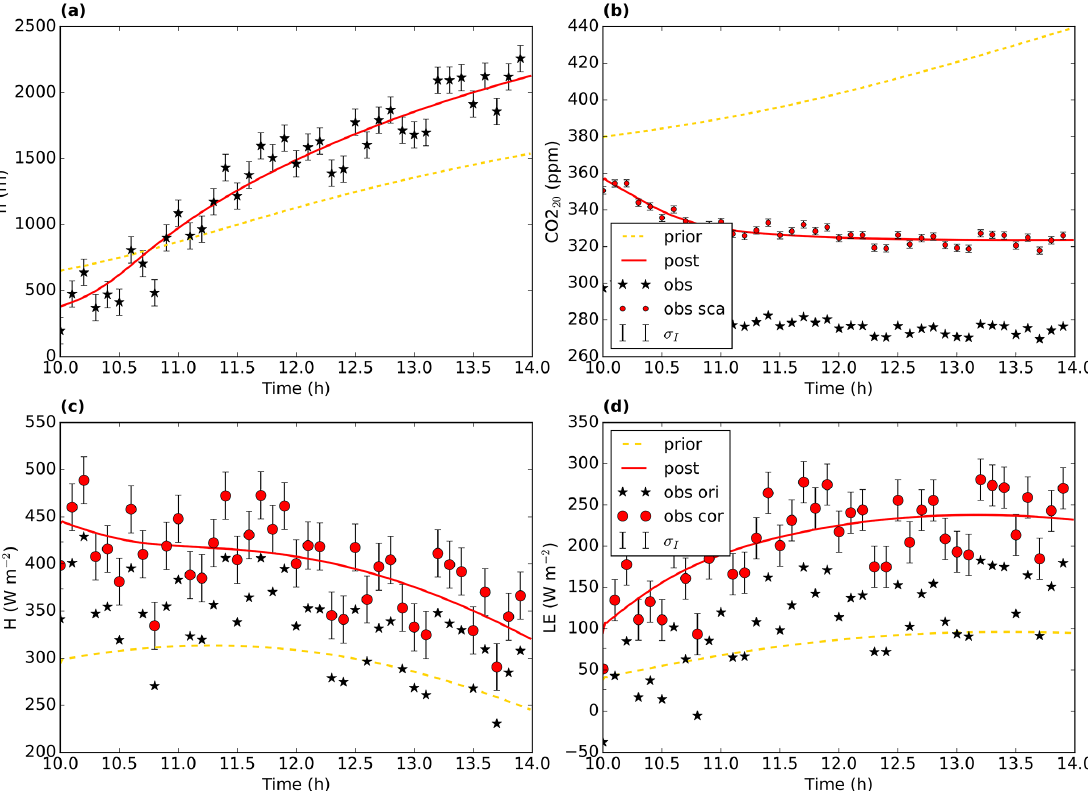
Figure 4. Model output and observations for the bias correction OSSE with perturbed observations. The full red line shows the optimised model (“post” means posterior), and the dashed yellow line is the prior model. The (uncorrected) observations are shown by a black star. The error bars show the measurement error standard deviation σ I (here equal to σ O ) on the observations. In panel (b) , the red-filled circles are the × y . In panels (c) and (d) , the black stars are the original (although perturbed) observations, and the red dots scaled observations, i.e. s CO 2 are the observations after applying Eqs. (8) and